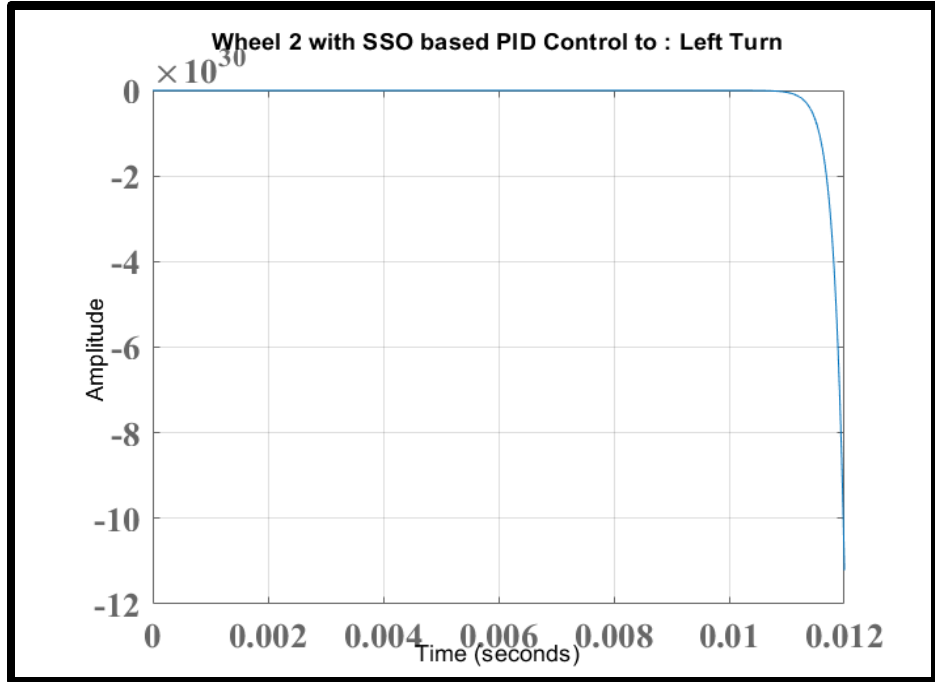
Figure 16. Simulation of wheel-2 turning left when V r < V L .